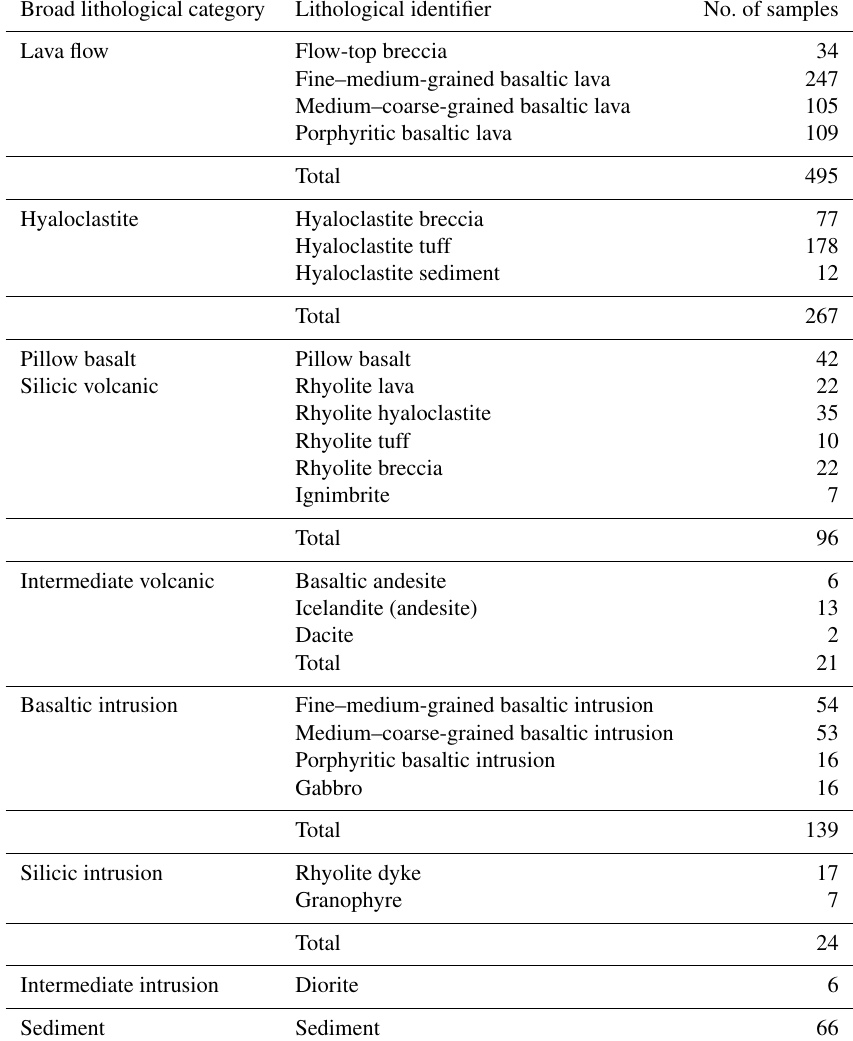
Table 2. List of lithological identifiers, detailed description of rock types covered by that identifier, and the number of samples in the database corresponding to each